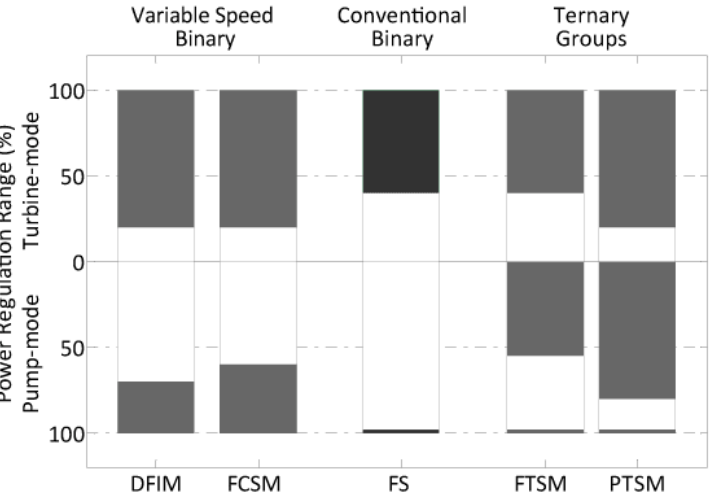
Figure 4. Comparison of power regulation ranges in turbine and pump modes for different technical solutions at the design head. FS: Conventional Fixed-Speed Synchronous Machine; DFIM: Double Fed Induction Machine; FCSM: Full Converter Synchronous Machine; FTSM: Francis Ternary Syn- chronous Machines with Hydraulic Short Circuit; PTSM: Pelton Ternary Synchronous Machines with Hydraulic Short Circuit.